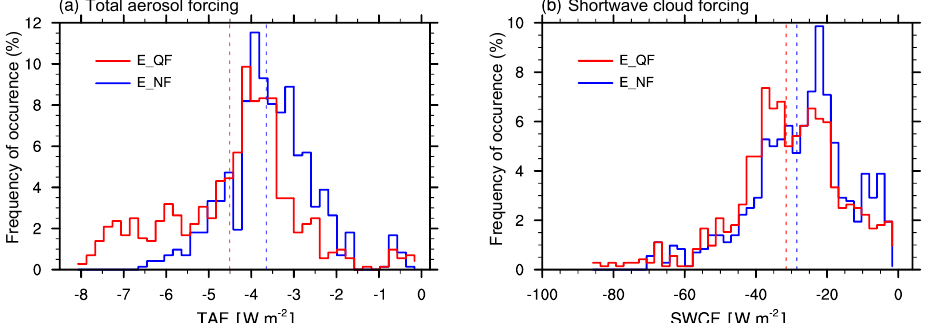
Figure 9. Probability distributions of 10-day-average (1–10 April) (a) total aerosol forcing and (b) total shortwave cloud forcing over southern Mexico in simulations E_NF and E_QF sampled from grid values of ensemble members (72 × 10 for each case). Dashed lines indicate the mean of the